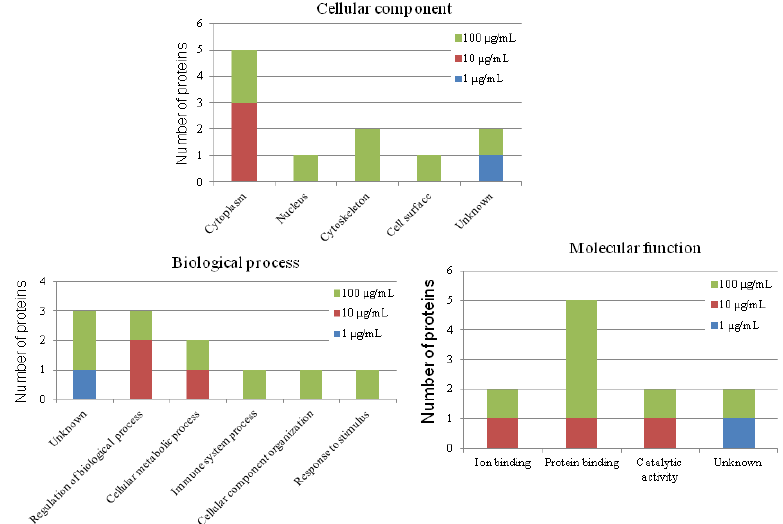
Figure 3. Gene ontology (GO) annotation of differentially expressed proteins in carbon nanotube-treated chicken macrophages. The original GO annotations were downloaded from the NCBI Entrez Gene database (Bethesda, MD, USA). The percentages are the total hits, divided by the number of annotated proteins for the